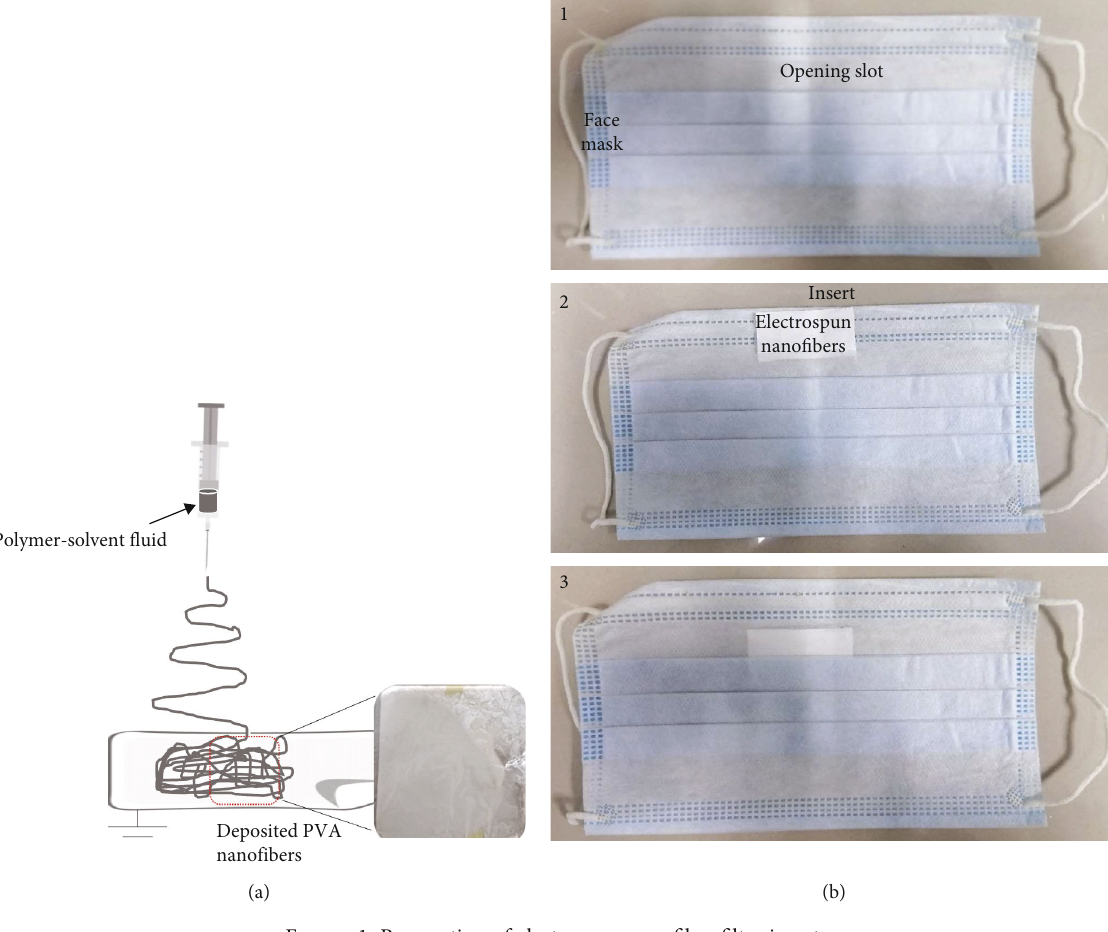
Figure 1: Preparation of electrospun nano fi ber fi lter